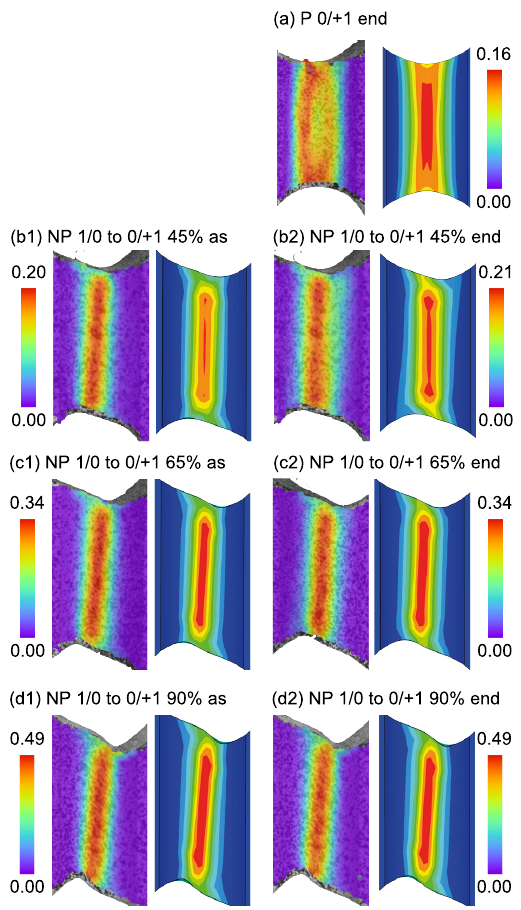
Figure 11. First principal strain by DIC ( left ) and numerical simulation ( right